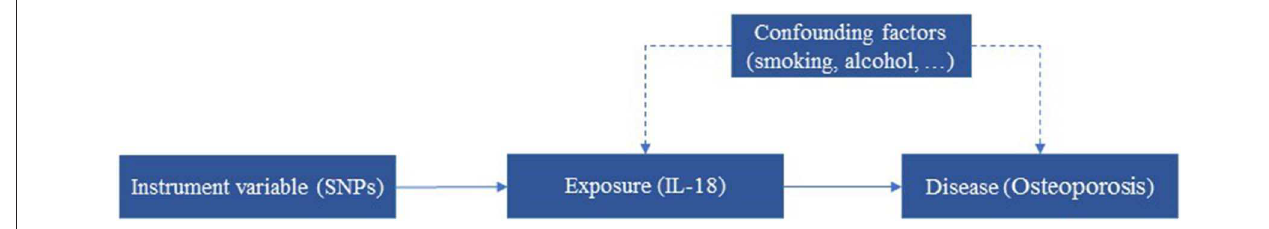
FIGURE 1 | MR analysis using SNPs as instrumental variables for estimating the influence of IL-18 on the risk of Osteoporosis.